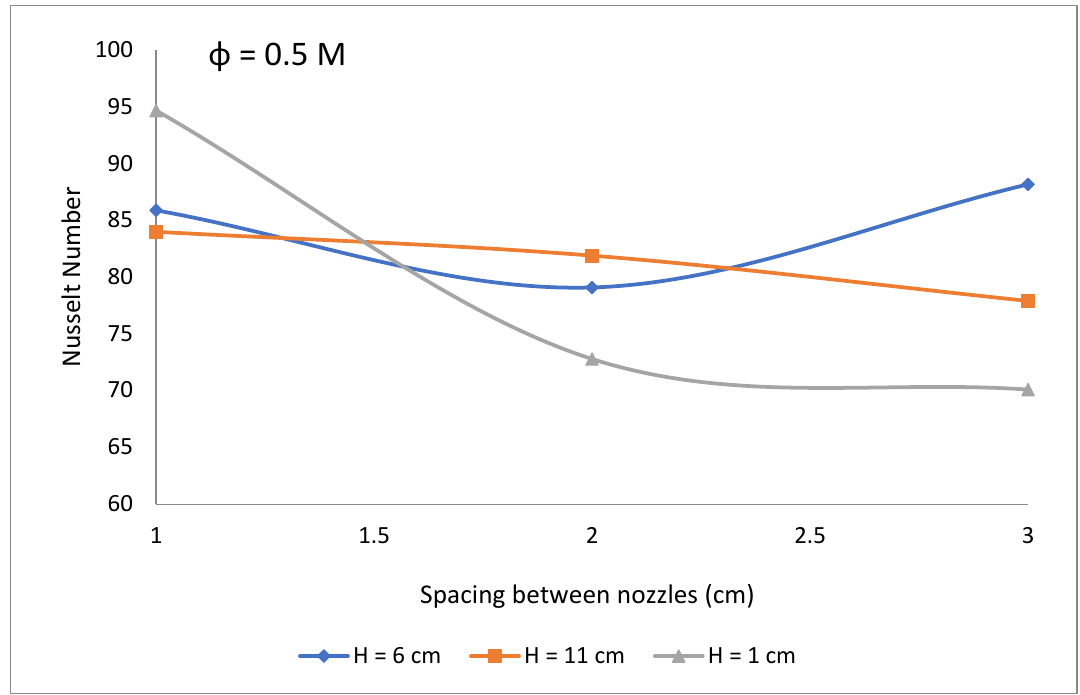
Figure 18. Interaction of nozzle-nozzle spacing and nozzle-plate distance levels at optimum levels of other factors.